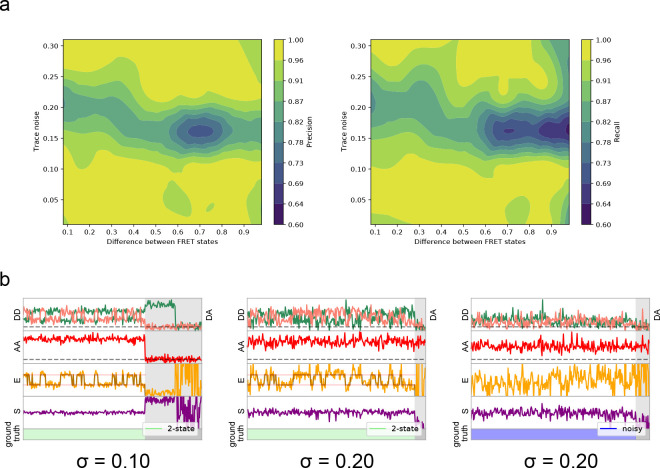
Relationship between model performance and noise level.(a) 3D illustration of the precision or recall (pseudocolor) as a function of trace noise and the distance between FRET states for dynamic 2-state traces. Prediction accuracy is minimal at ~0.2 noise levels. At lower noise, the trace is accepted and correctly classified with an accuracy of >0.96, while at high noise levels the trace is accurately classified as non-FRET. (b) Examples of simulated dynamic traces used, with input simulation noise. At a high simulated noise level, only some traces are below the lower limit of acceptable noise, when measuring the per-state standard deviation of FRET of the final output trace.